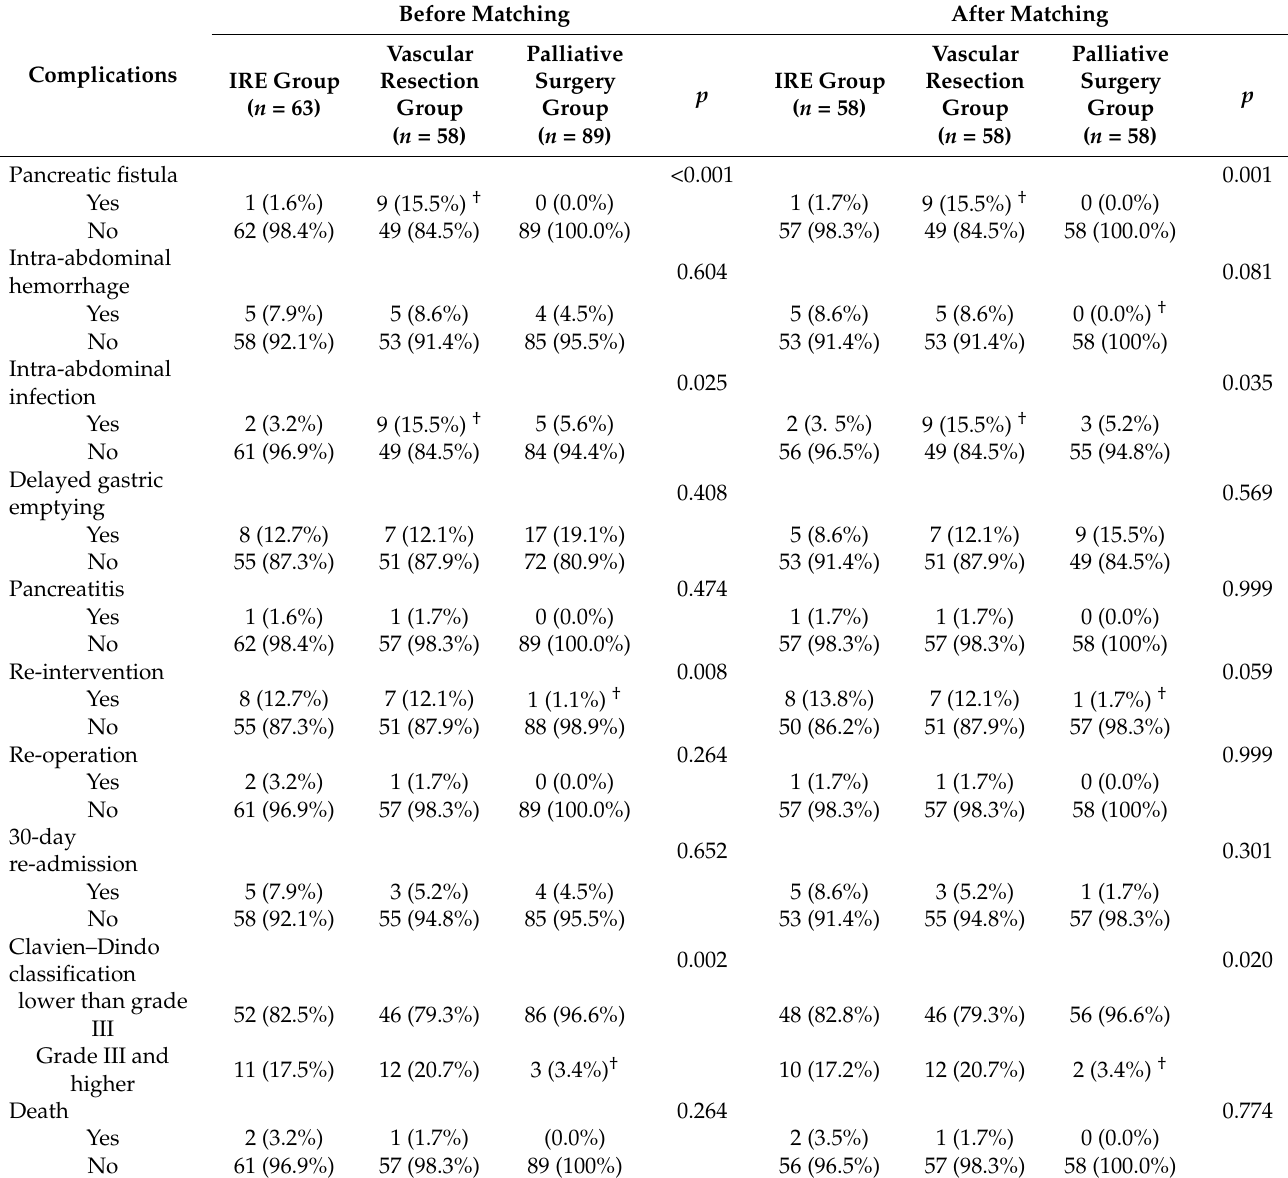
Table 2. Post-operative short-term outcomes of the